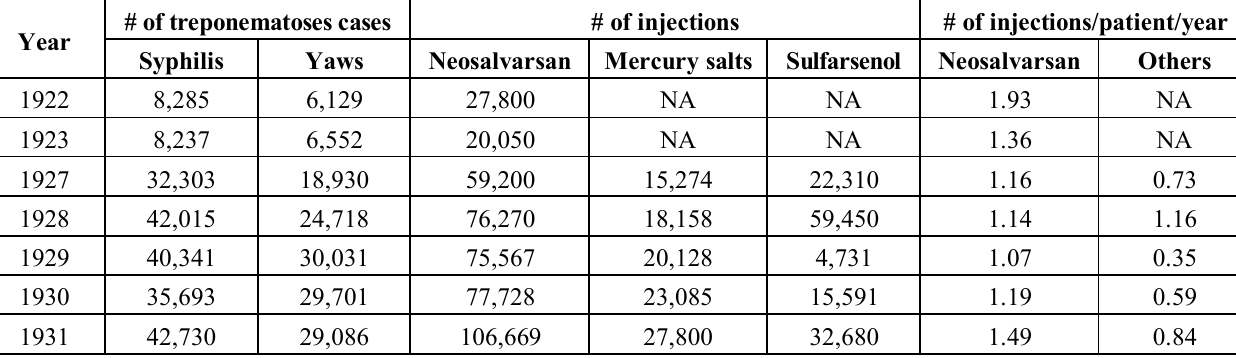
Table 1. Injection treatments against treponematoses in Cameroon, 1922–1931. Sources: [50,88,105].